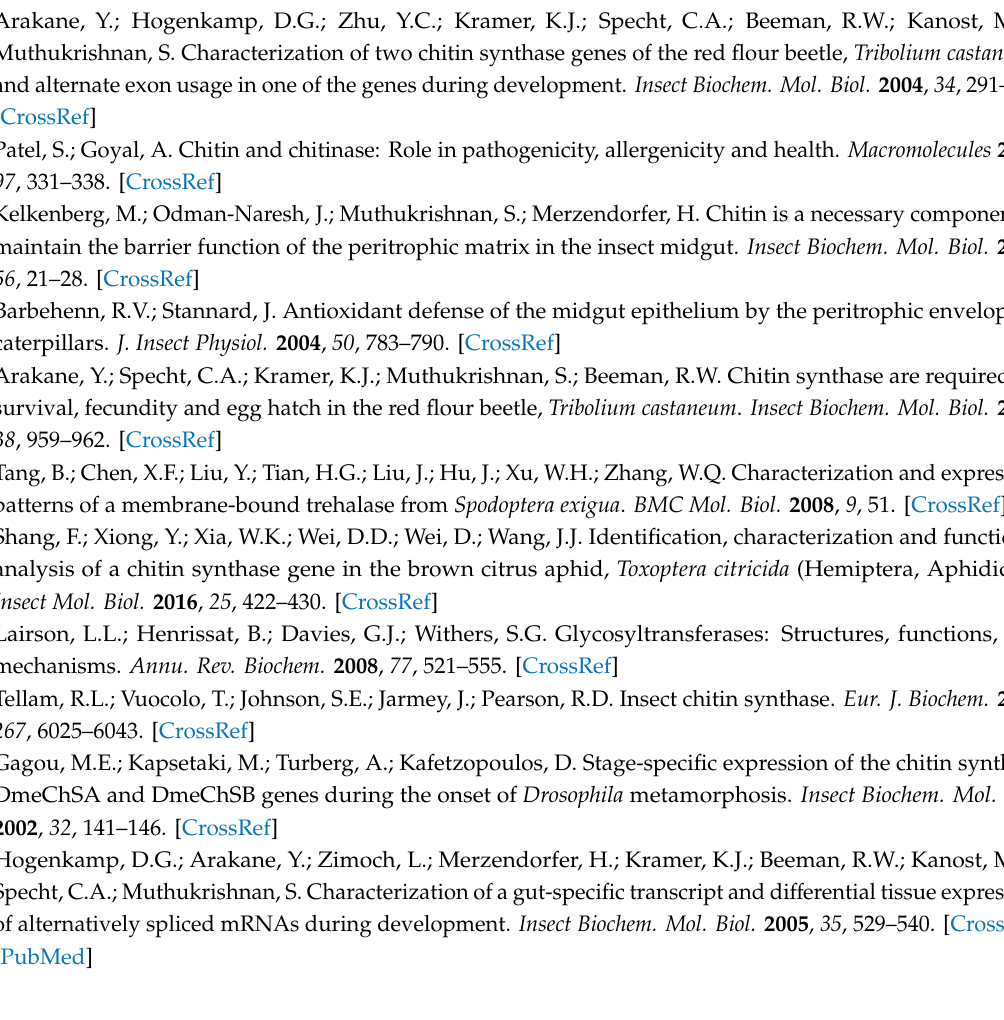
Table S1: Sequences and relevant information used for phylogenetic analysis of the chitin synthase genes. Figure S1: Nucleotide and deduced amino acid sequences of SlCHS1 cDNA from S. litura . Figure S2: Nucleotide and deduced amino acid sequences of SlCHS2 cDNA from S. litura